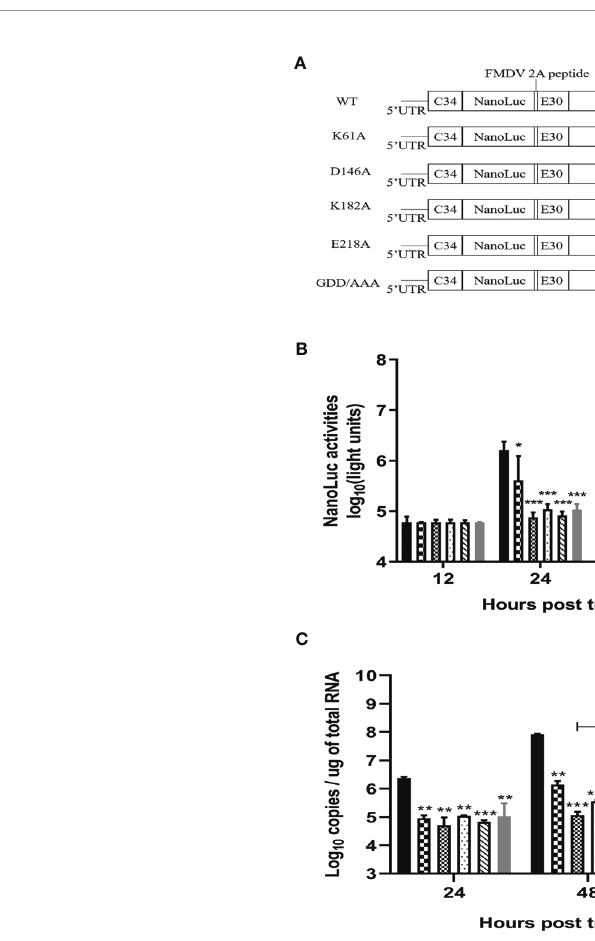
FIGURE 4 | K-D-K-E mutations may reduce translation ef fi ciency of TMUV luciferase reporter replicon. (A) schematic diagram presentation of WT and mutant TMUV replicons. (B) NLuc activity assay. BHK-21 cells were transfected with equal amounts of WT and mutant replicons. At 12, 24, 48 and 72 h post-transfection, the cells were lysed, and NLuc activities were measured. Each of these was conducted with three parallel replicates. Bars show means ± SDs. *** P < 0.001; ** P < 0.01; * P < 0.05 (two-way ANOVA) (C) Copy numbers of replicons were determined by absolute qPCR. Each of these was conducted with three parallel replicates. Bars show means ± SDs. *** P < 0.001; ** P < 0.01; * P < 0.05 (two-way ANOVA). ns, no signi fi